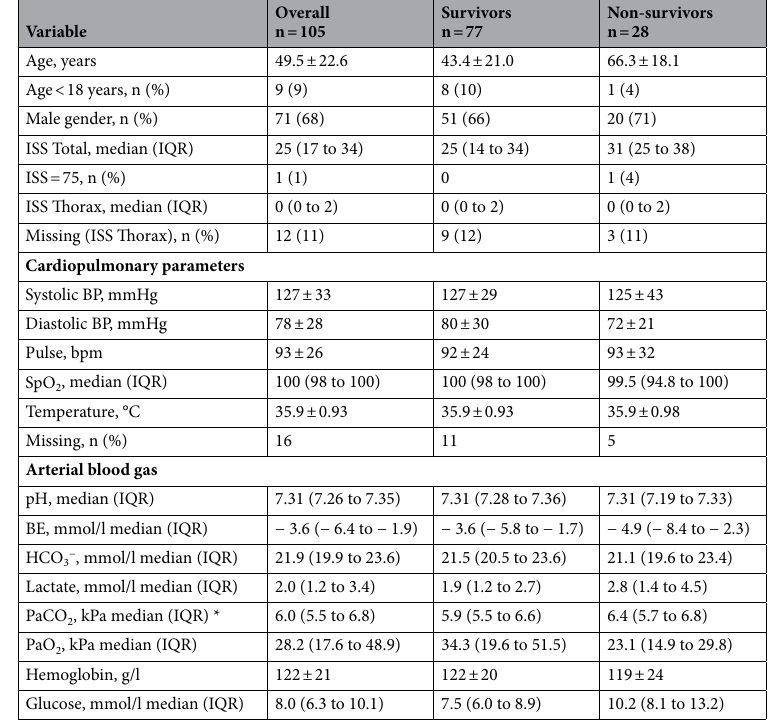
Table 1. Baseline characteristics of patients. Data was complete if not otherwise specified. Continuous variables are reported as mean ± SD = (standard deviation) if normally distributed and not stated otherwise. BP blood pressure, IQR interquartile range, ISS injury severity score, bpm beats per minute, SpO 2 peripheral capillary oxygen saturation. *PaCO 2 = same parameter as shown in detail on Table 2 (initial